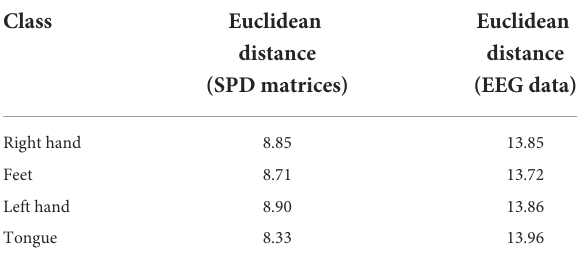
TABLE 6 The averaged Euclidean distance among different subjects of SPD matrices and EEG data in the feature